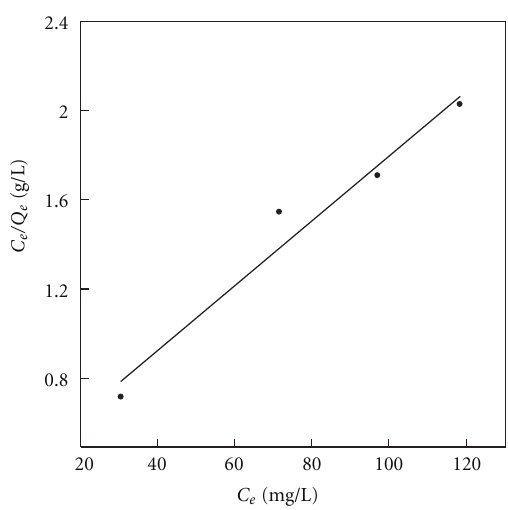
Figure 4: Langmuir isotherm plots of phenol adsorption onto BK (initial concentrations = 100–500 mg L − 1 , 25 ◦